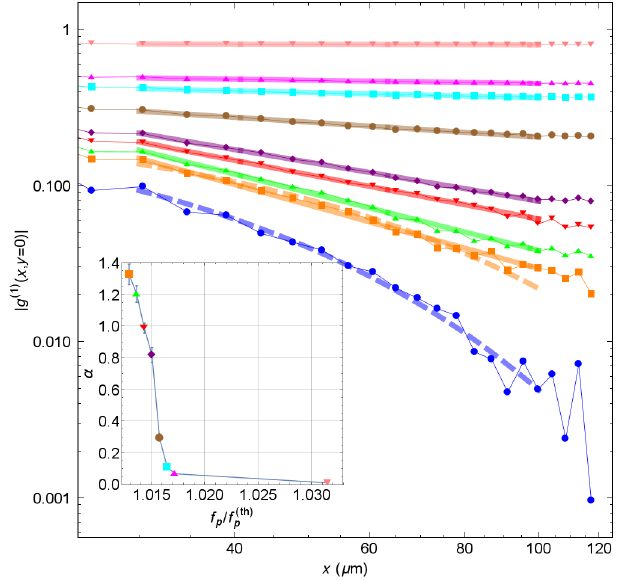
FIG. 4. Algebraic and exponential decay of the first-order correlation function across the BKT transition. Main panel: Long-range spatial dependence of g ð 1 Þ ð r Þ for different pump =f th powers f close to the mean-field pump threshold (the p p symbols are the same ones as in the inset and correspond to =f th the same values of f ). Thick solid (thick dashed) lines p p are power-law (exponential) fitting, from which values of the 1 . 0129 case (orange =f th exponent α are derived. The f p ¼ p squares) is a marginal case where both algebraic and exponential fits apply almost equally well, signaling the BKT transition region. Inset: Power-law algebraic decay exponent α for different =f th pump powers f ; error bars are standard deviations of the p p